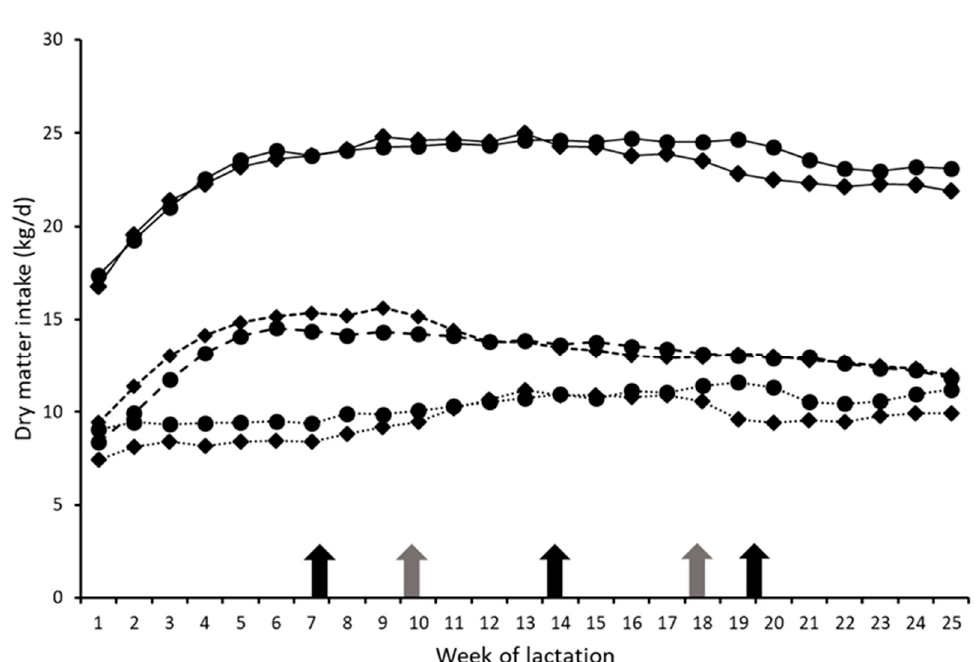
Figure 1. Mean weekly silage DMI (dotted lines), concentrate DMI (dashed lines) and total DMI (solid lines) of cows offered silage produced within either a three- (3H; (cid:117) ) or four-harvest (4H; • ) system. Arrows indicate when cows changed to harvests 2,3 and 4 (4H; black arrow) and harvests 2 and 3 (3H; grey arrows).